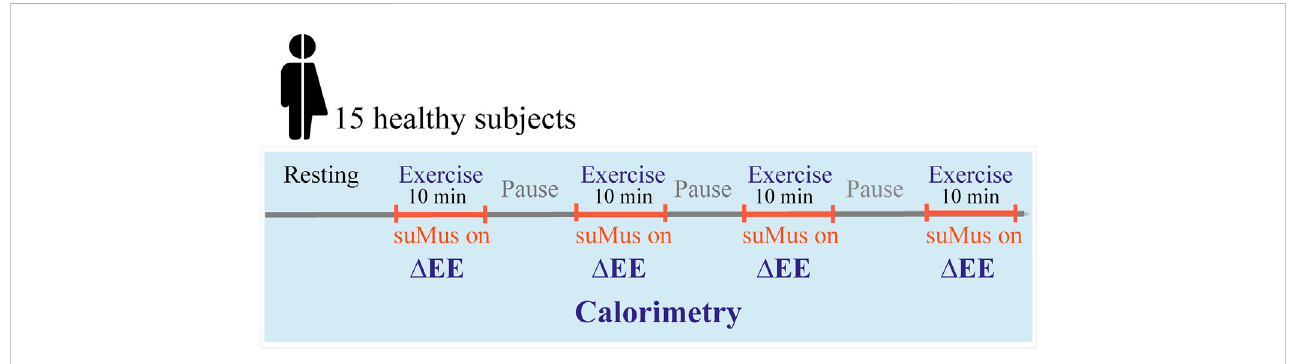
FIGURE 1 Study design for calorimetry and movement measuements. Subjects performed four different exercises in the metabolic chamber with de fi ned resting periods.Movementmeasurementwererecordedduringexercisesindicatedinorange,whilethemetabolicchamberrecordedalsoduringtherestingperiods. Δ EE: difference of energy expenditure between exercise and pause